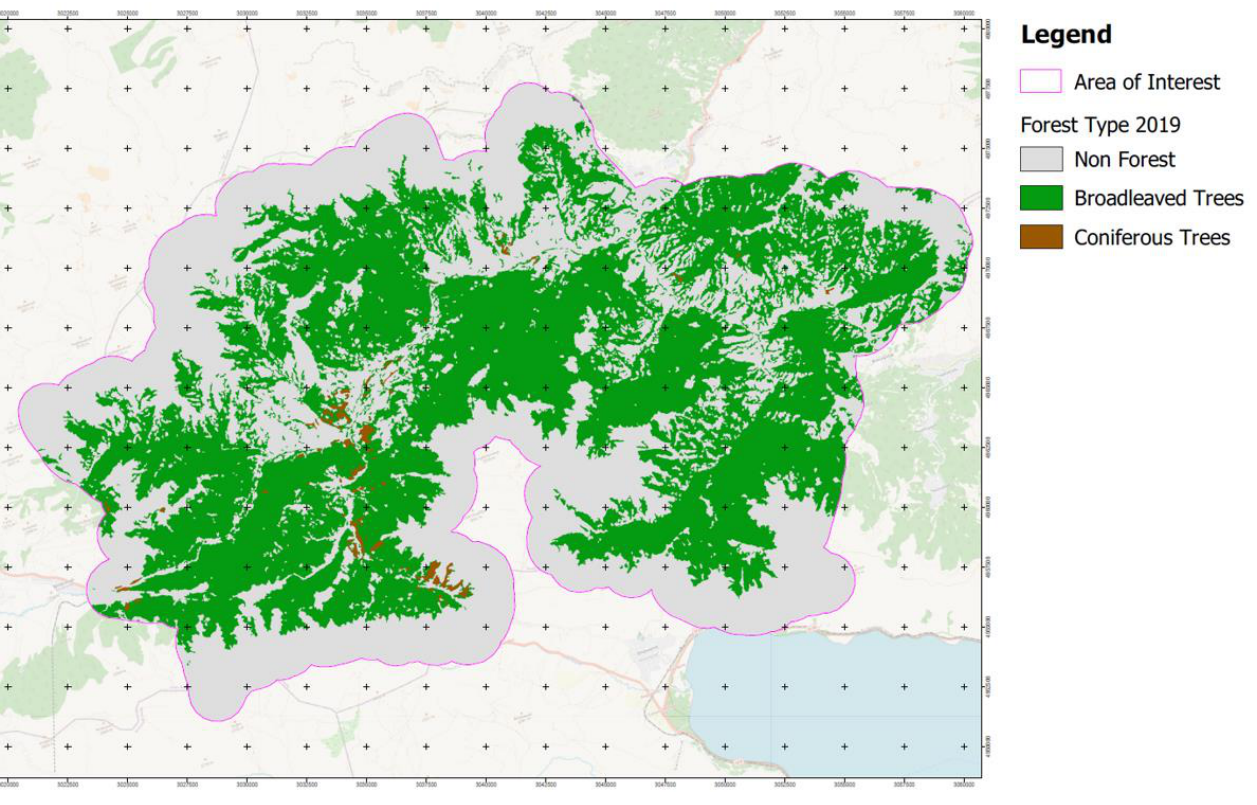
Figure 10 . Forest Type year 2019 . Figure 10. Forest Type year